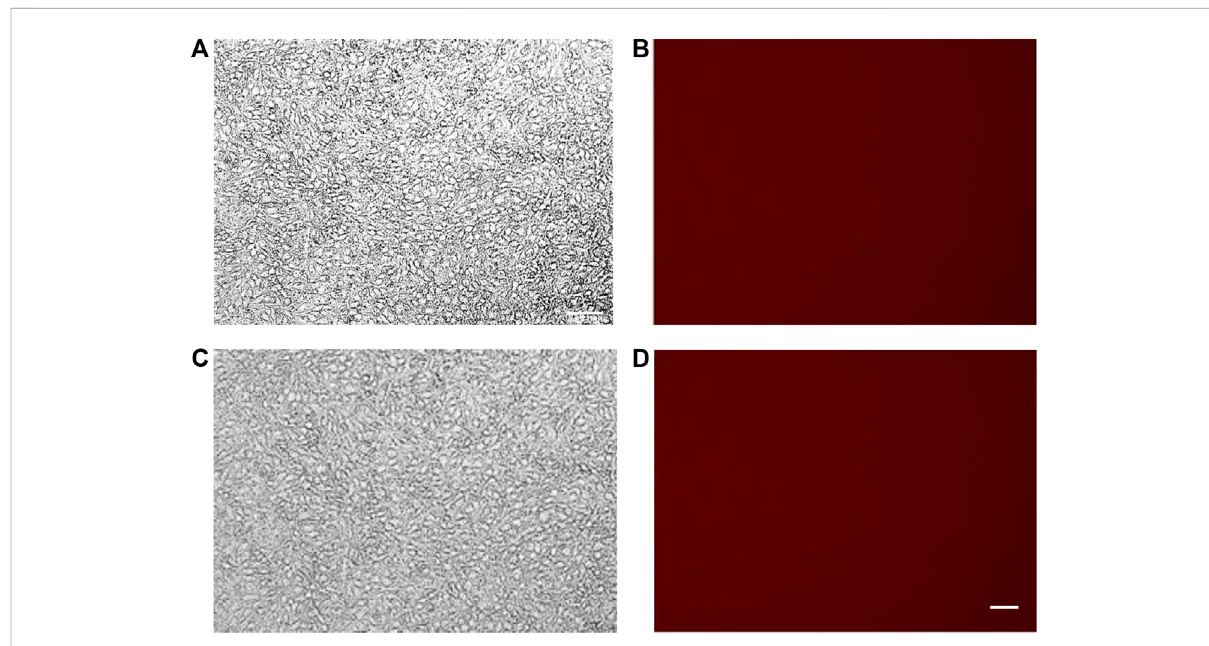
FIGURE 8 bEnd.3 before (A , B) and after (C , D) PACAP loaded functionalized liposome passage. bEnd.3 seeded in the LiveBox2 bio incubator do not retain red fl uorescence (no PACAP-Rho) indicating that PACAP-Rho loaded functionalized liposomes pass the bEnd3 endothelial layer and become available in the LiveBox2 bottom chamber. The scale bar was 20